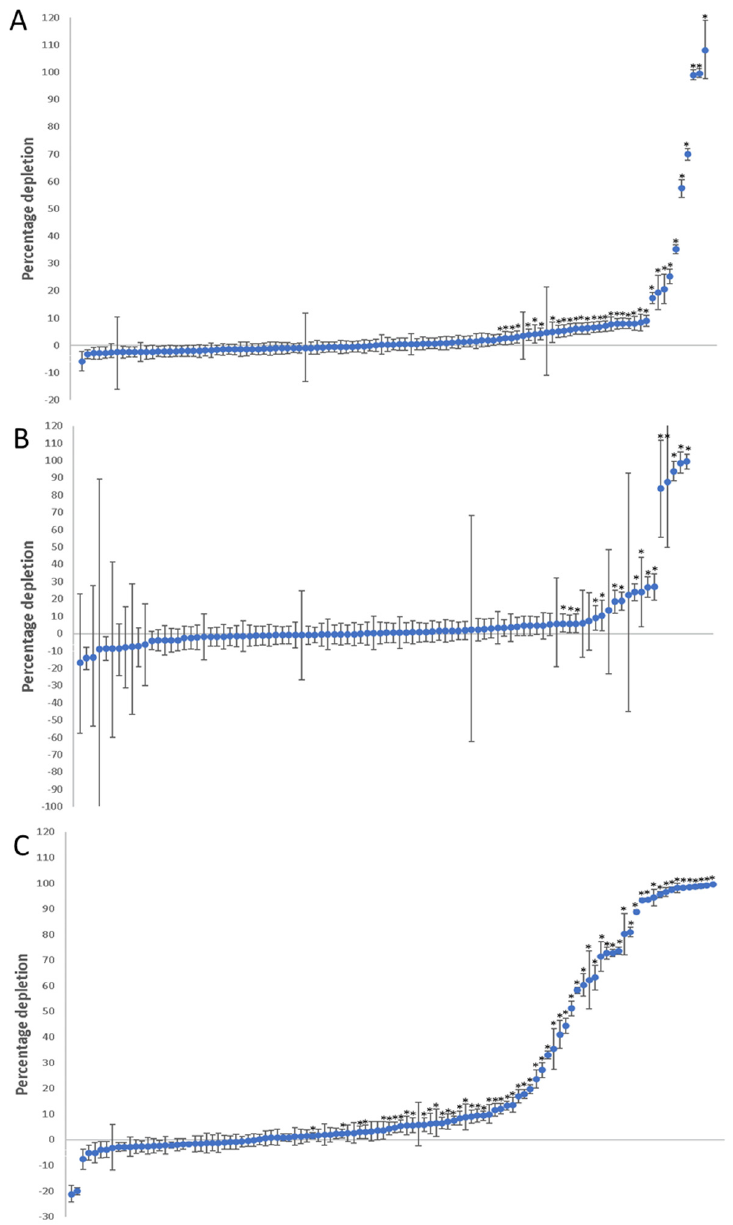
Figure 5. Values obtained from NBT ( A ), PDA absorbance ( B ), and PDA fluorescence ( C ) percentage depletion for test compounds. Data points and error bars indicate the mean and 95% confidence intervals determined using Bayesian modeling. Each data point represents the data for a TC in a particular run. Asterisks (indicated by *) indicate statistically significant results where the 95% confidence interval does not overlap with zero. Data is arranged from lowest to highest percentage depletion. Compounds with negative percentage depletion values less than − 20% or percentage depletion values greater than 110% are excluded.